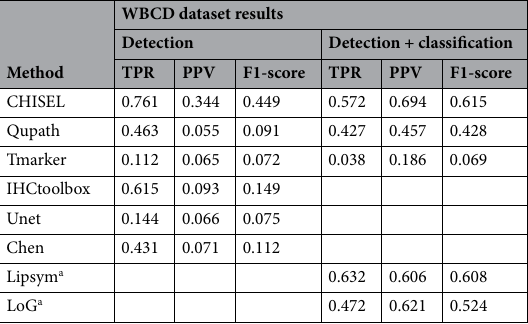
Table 2. The results of detection and detection followed by classification of CHISEL and other state-of-the-art methods based on the processing of the Warwick Beta Cell Dataset. a Results directly from publication 11 .